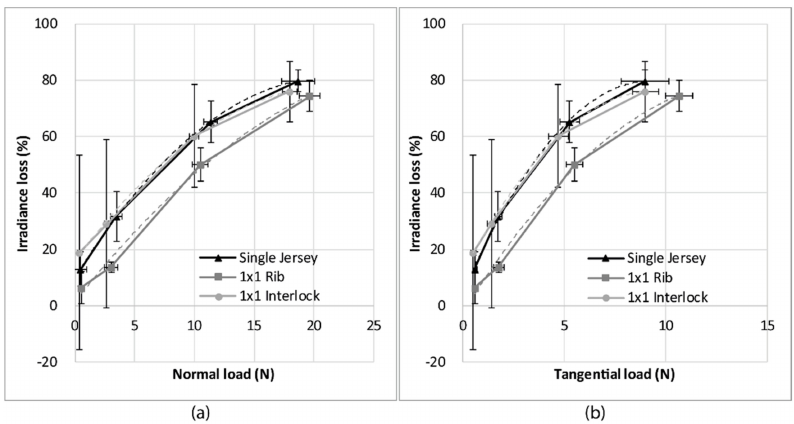
Figure 13. Evolution of the irradiance loss relative to ( a ) the normal load applied and ( b ) the tangential load for the three knitted fabrics, with the error bars representing the standard deviation.